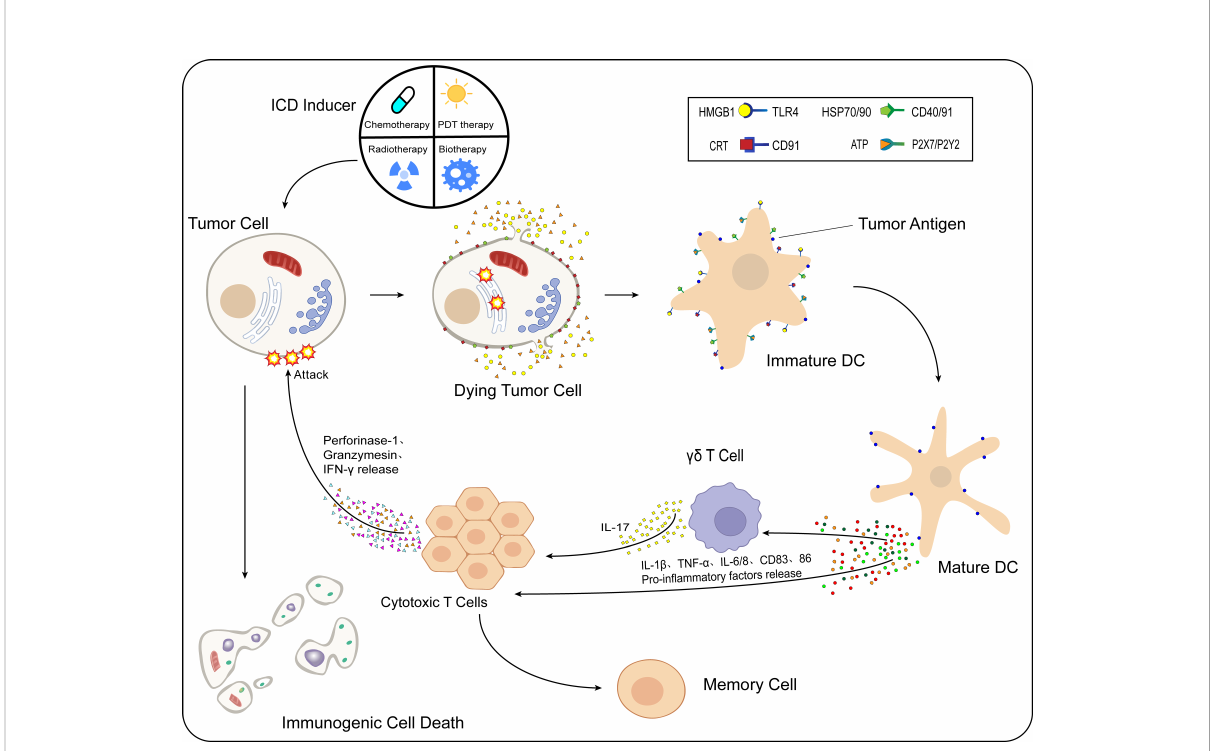
FIGURE 1 Process of immunogenic cell death (ICD). After the action of ICD inducers on tumor cells, different classes of inducers cause the onset of the endoplasmic reticulum stress response by direct or indirect means. Under the in fl uence of multiple intracellular mechanisms of action, CRT and HSP70/90 present in the cell are exposed to the cell surface, while ATP and HMGB1 are released to the extracellular compartment via vesicular transport. These released DAMPs bind to immature DCs in the TME. HMGB1 binds to TLR4 receptors, CRT binds speci fi cally to CD91, HSP70/90 binds to CD40/91 receptors, and ATP binds speci fi cally to different P2X7/P2Y2 receptors at different concentrations. Moreover, DCs mature in the TME, while the antigen-presenting function is further enhanced. Under the action of mature DCs, levels of proin fl ammatory cytokines such as IL-1 b , TNF- a , IL-6/8, and CD83/86 in the TME are increased. IL-1 b acts on gd T cells and CTLs, while gd T cells release IL-17, and under the combined effect of IL-1 b /17 and other cytokines, the CTLs release perforin-1, IFN- g , granulocyte enzymes, and other substances that cause kill effects on tumor cells, and ICD occurs in tumor